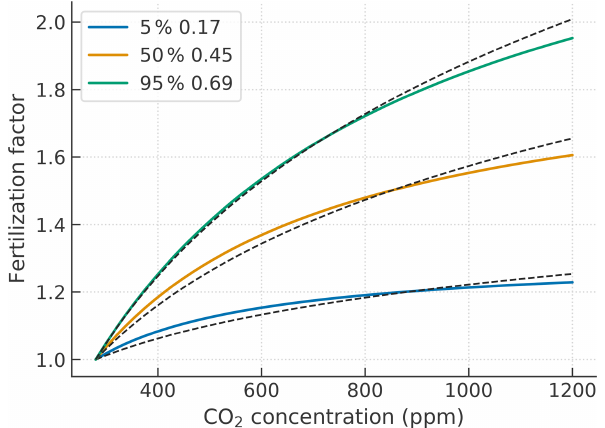
Figure 8. Effective radiative forcing (ERF) of CO 2 as a function of the ratio of CO 2 concentrations to a preindustrial level. The scaling parameter α C is set to three different values, corresponding to the 5th, 50th, and 95th percentiles of the Prior ensemble described in Sect. 3.1. For each α C value, the amplification factor β C is varied between the 5th and 95th percentiles (shaded area) and is set to two specific values of the 50th percentile (solid line) and unity (dashed line, no